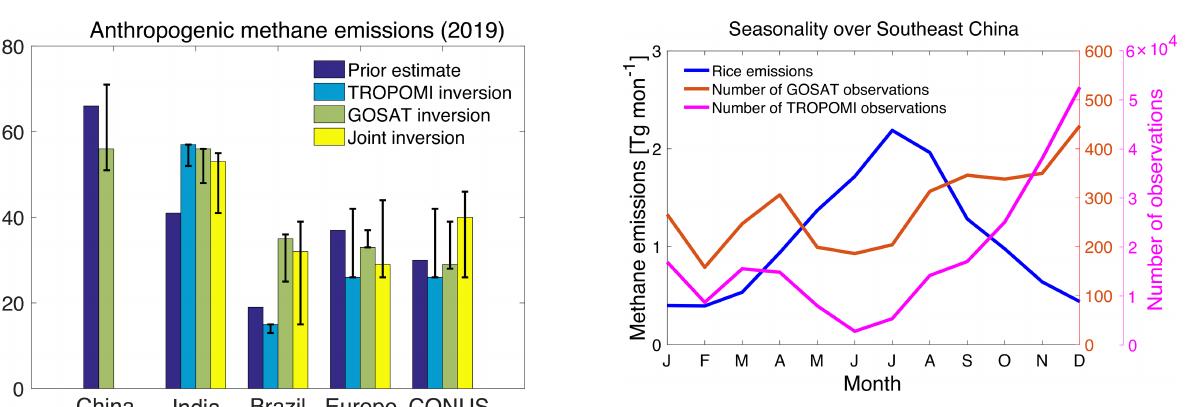
Figure 8. Seasonality of methane emissions from rice cultivation and satellite observation frequency over southeast China (20–37 ◦ N, 103–123 ◦ E, shown in Fig. 4) in 2019. The number of TROPOMI observations increases after August 2019 due to change in pixel size from 2km × 2.5km to 5.5km × 7km. Seasonality of rice emissions is from B. Zhang et al. (2016). Note the difference in scale for the number of observations by TROPOMI and